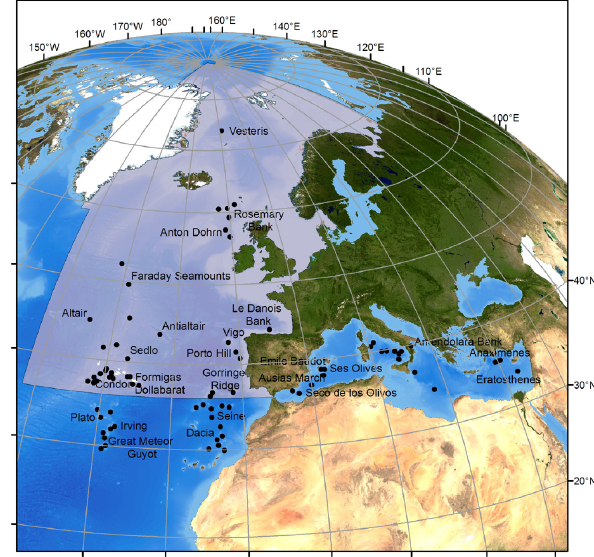
Fig. 8. Locations of seamounts in the north-east Atlantic and Mediterranean Sea that have been sampled for geology, biology or oceanography data (for list of seamounts, see Supplementary Mate- rial 5). Shaded layer shows the limits of the OSPAR